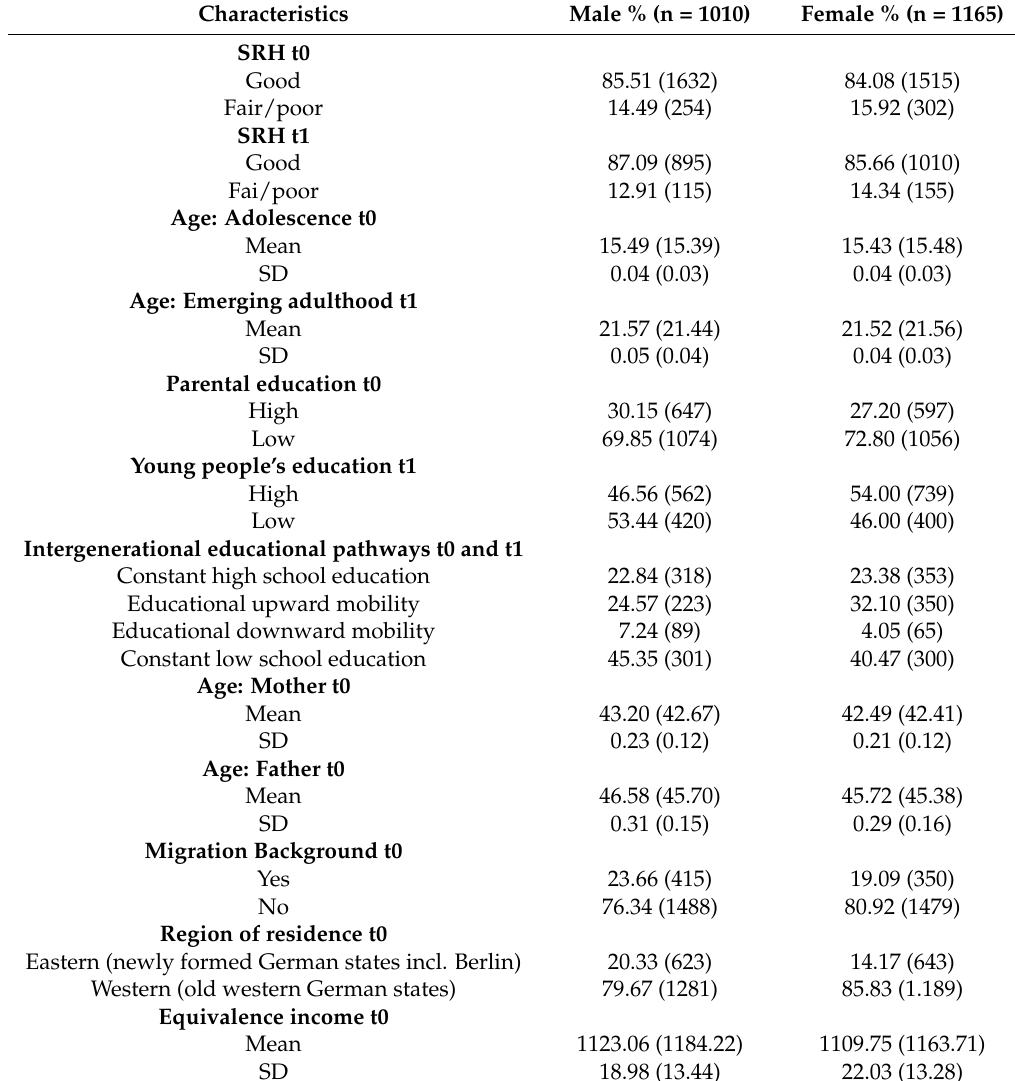
Table 1. Description of the study sample (n =